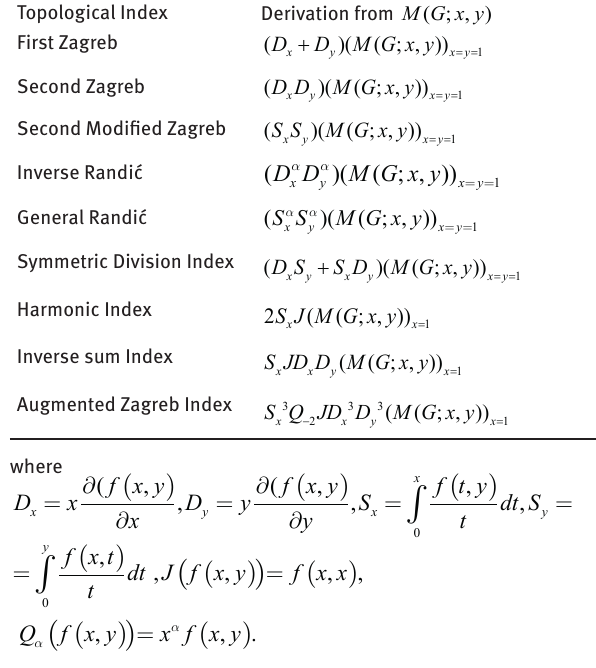
Figure 3: Dominating David derived network of the third type D Table 1: Derivation of some degree-based topological indices from M